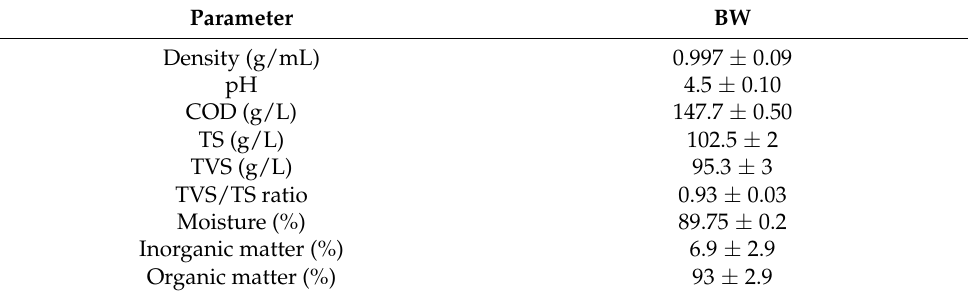
Table 1. Physicochemical characterization of